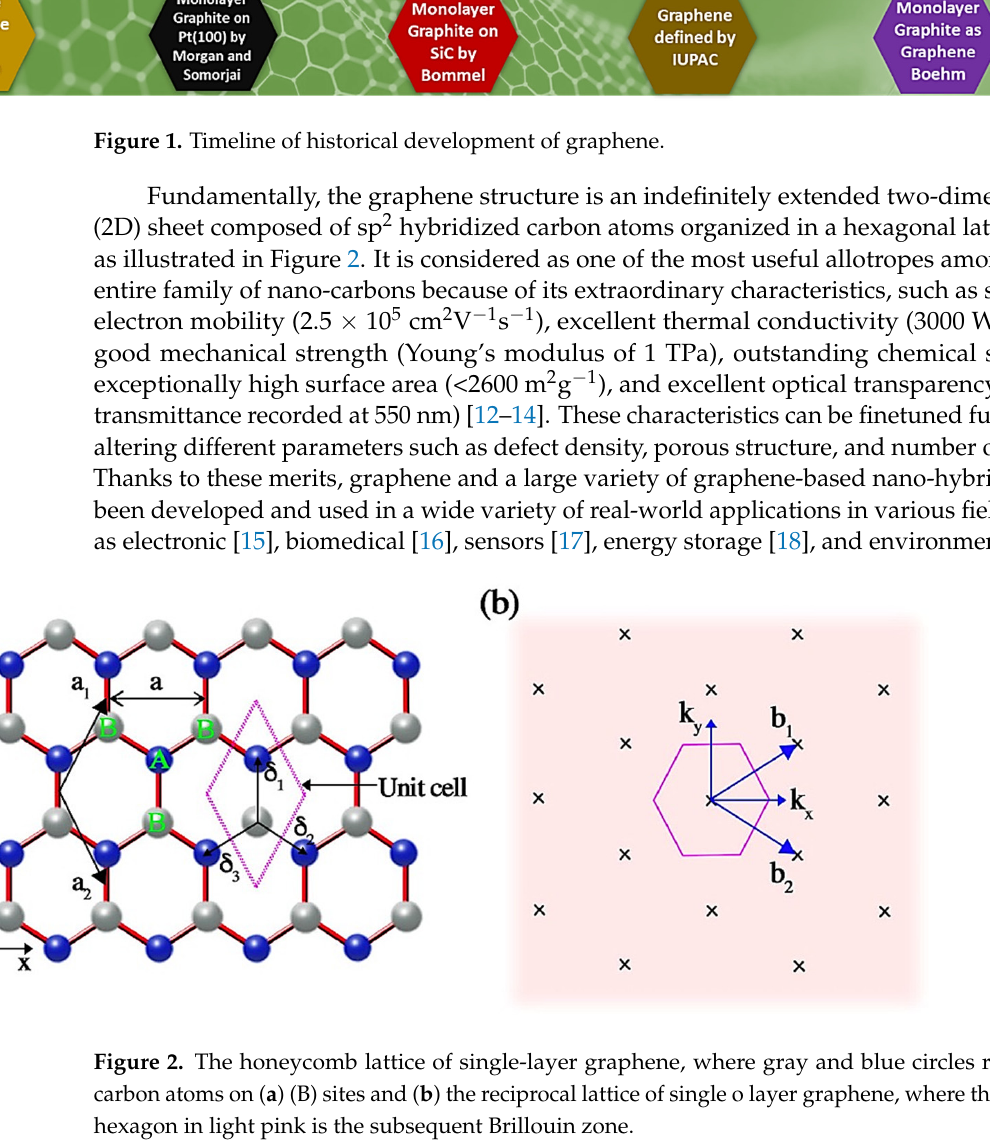
Figure 1. Timeline of historical development of graphene.